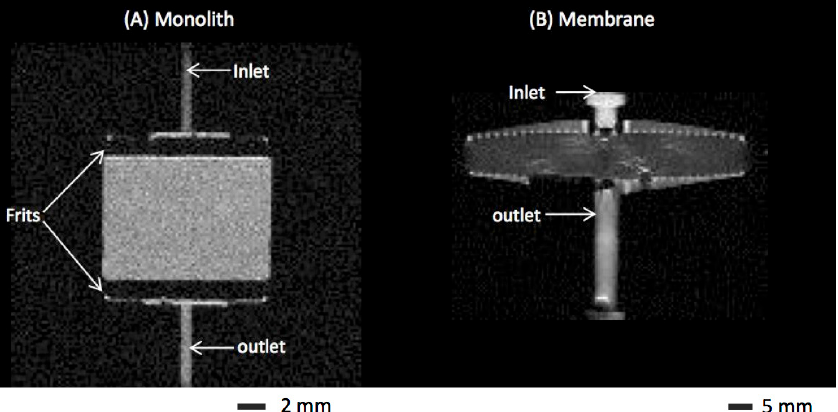
Figure 1. Visualization by MRI of the chromatographic devices: ( A ) CIM housing containing 3 discs of monolith ( H = 9.0 mm), ( B ) Sartobind S75 device containing 15 membranes ( H = 4.0 mm).